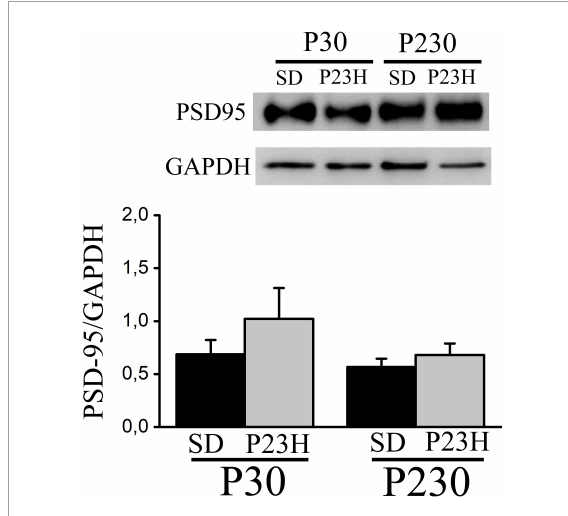
FIGURE6 Western blot showing PSD-95 from the extracts of the visual cortices of the control SD and P23H rats at P30 and P230. The antibody recognizes a band of approximately 100 kDa. No differences among groups were found. Detection of GAPDH was included as an internal control and used to calculate the relative amount of PSD-95.